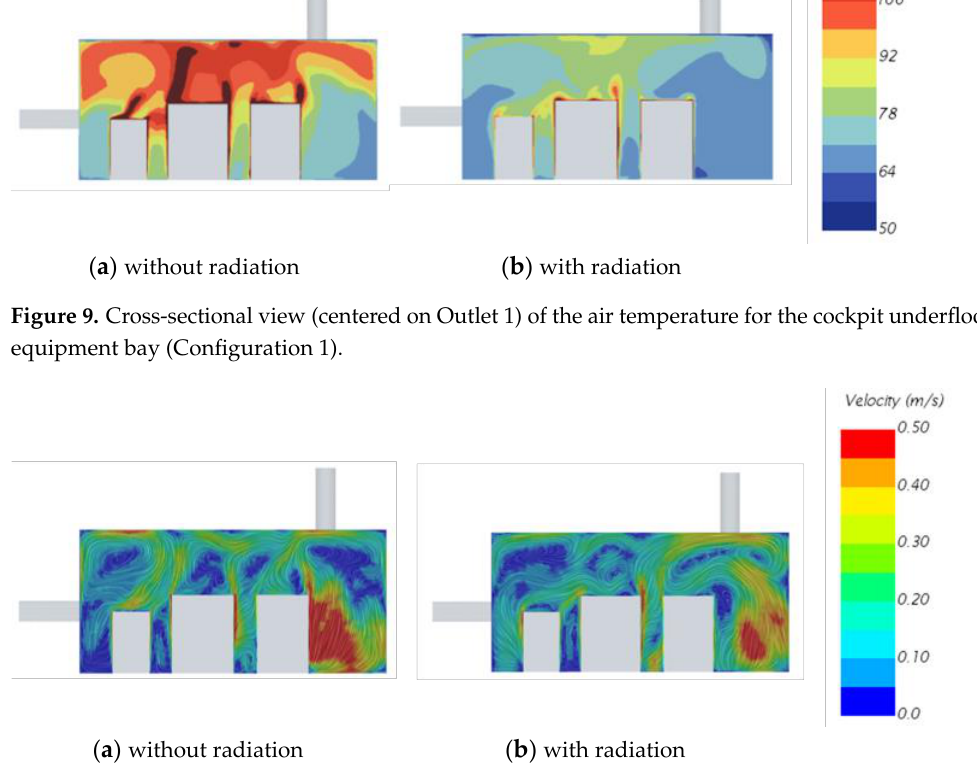
Figure 12. Velocity streamlines from inlets 1, 2, and 3 for the underfloor equipment bay (Configu- ration 2). Group 1 contains systems 1, 2, 3 and 4, located between the outlet and inlets 1 and 2 (cabin exhaust). Group 2 includes systems 5, 6 and 7 in front of inlets 1 and 2. Finally, Group 3 contains system 8 facing inlet 3 (cockpit exhaust). To assess the proportion of radiation in the overall system heat transfer, the radiative and the total system heat fluxes are derived from the CFD results and used to calculate the radiative heat flux ratio. Figure 13 shows the evolution of this ratio averaged per group with the system distance.